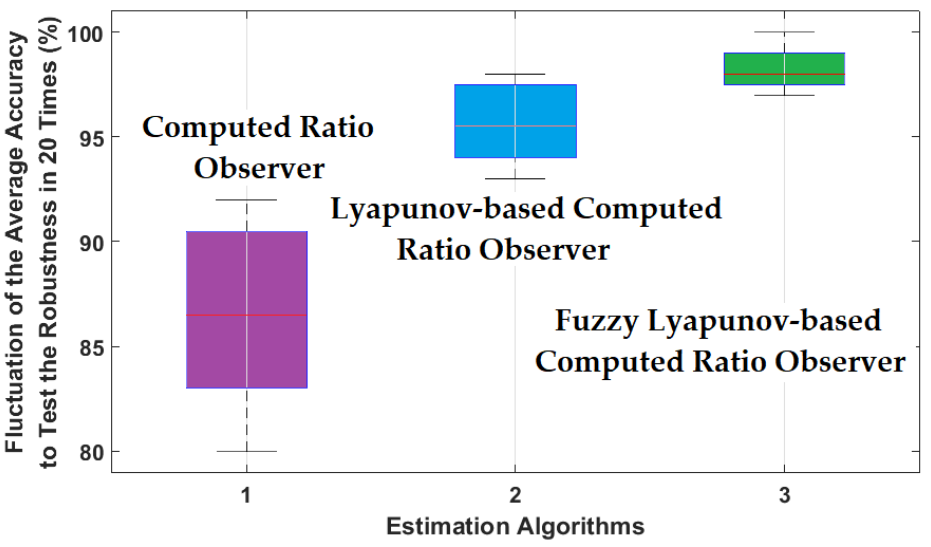
Figure 13. Fluctuation in average accuracy, which indicates the robustness of the FGAL-CR method, the FGAL-LCR technique, and the proposed FGAL-FLCR approach.